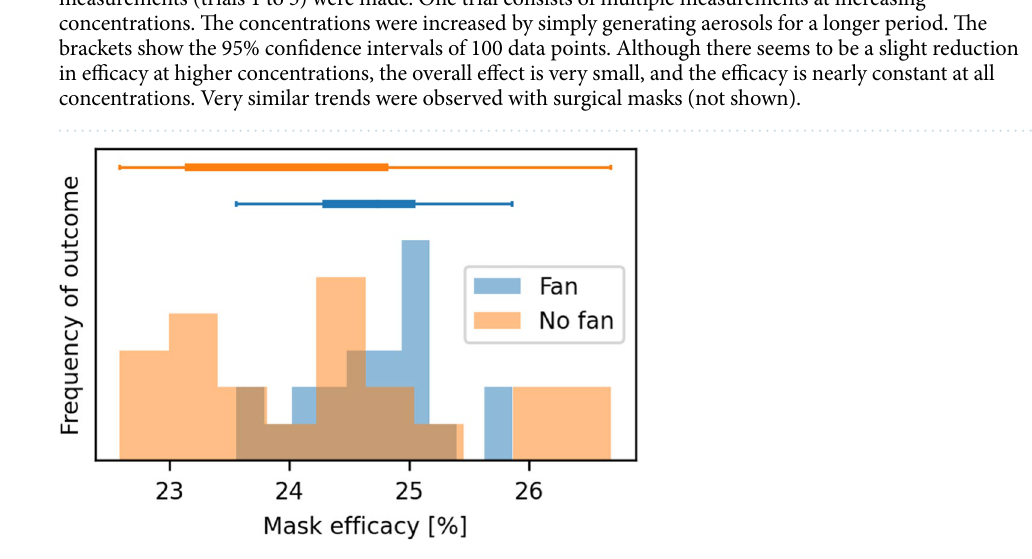
Figure 7. Differences in measurements when using a fan behind the emitter. The plot shows 22 repeated measurements of surgical masks’ efficacy on the receivers’ head. The blue values were recorded with a fan behind the emitter. The horizontal boxplots on top show the distribution of the first and third quartile (solid box), while the whiskers show the minimum and maximum values. The Wilcoxon signed-rank test and Kruskal–Wallis-Test showed no significant difference ( p > 0.11). That means that using a fan behind the emitter to gently blow the aerosol towards the receiver does not significantly alter the measured